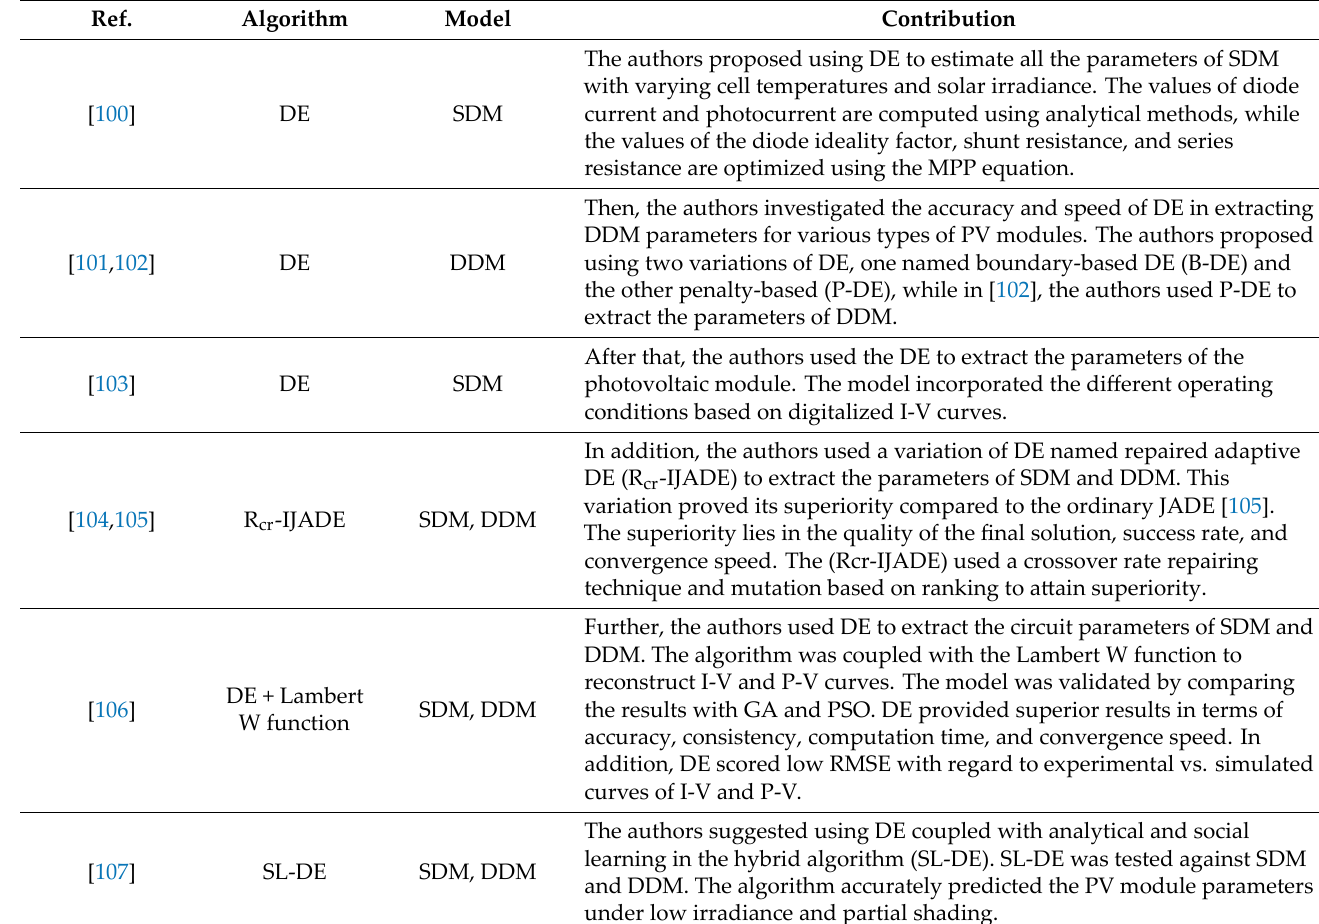
Table 6. Soft computing algorithms—evolution‑based metaheuristic algorithms.